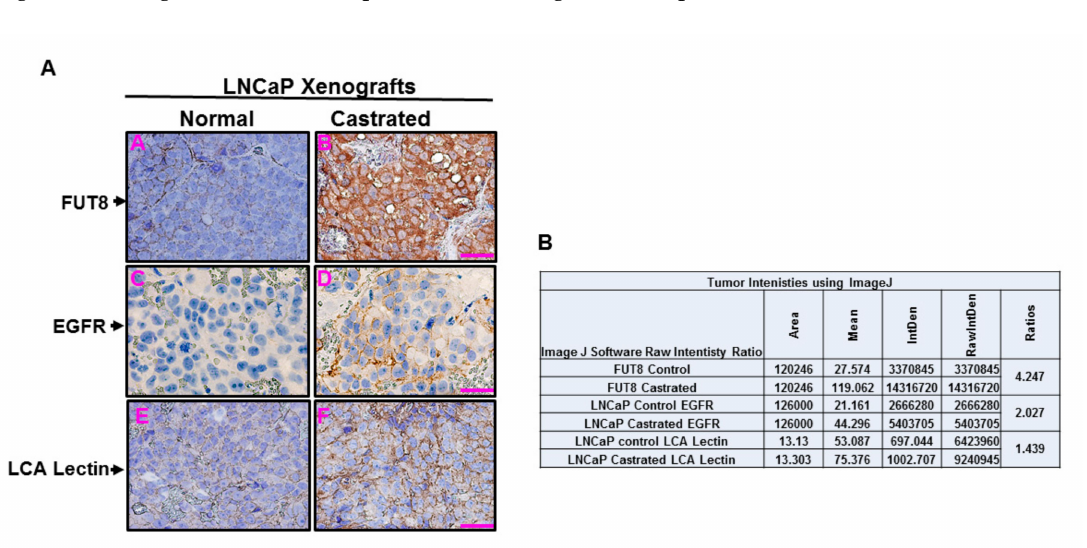
Figure 6. Castration-induced FUT8 expression is associated with EGFR. LNCaP cells that were inoculated as xenografts in nude mice were either castrated or mock operated after the tumor volume reached around 1 cm 3 . Five weeks after the castration all the mice were sacrificed and tumors were removed for Immunohistochemistry (IHC) staining using FUT8, EGFR, and with Lens culinaris (LCA) lectin staining. For each antibody two di ff erent tumors were stained. Images were taken using 40x magnification and quantified using ImageJ software ( A , B